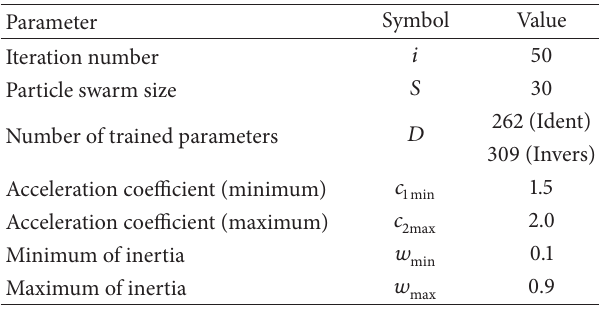
Table 1: Parameter for PSO-DIC.